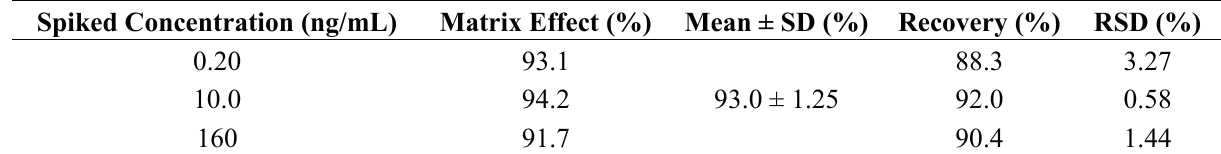
Table 1. Matrix effects and recoveries of PD in rat plasma ( n =